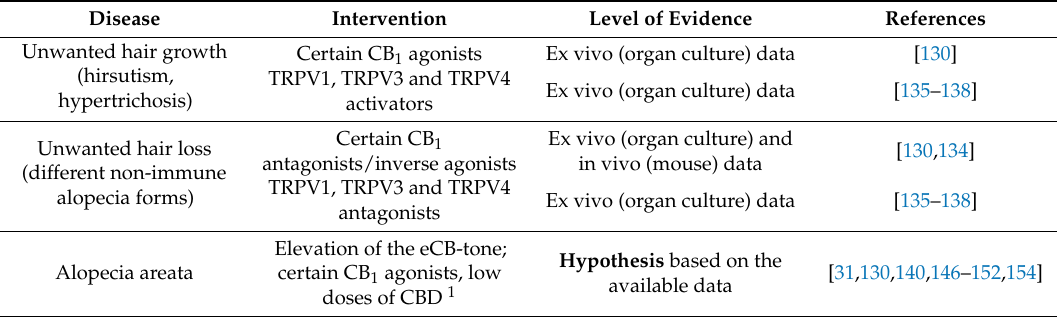
Overview of the putative hair-relevant therapeutic potential of cutaneous cannabinoid